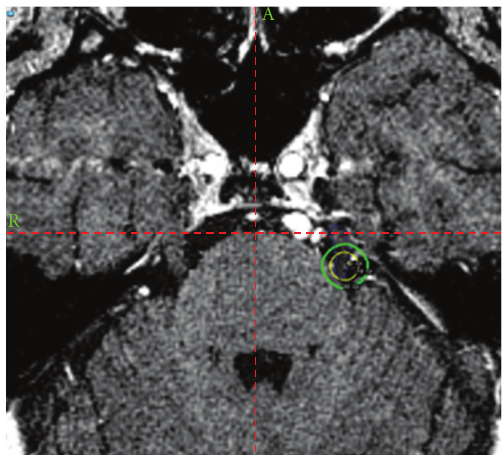
Figure 1: Axial section through the brainstem at the nerve root entry zone of the left trigeminal nerve with an illustration of the location of the 50% isodose line for gamma knife radiation treat- ment planning. This was the treatment location for the first and sec- ond gamma knife procedures.